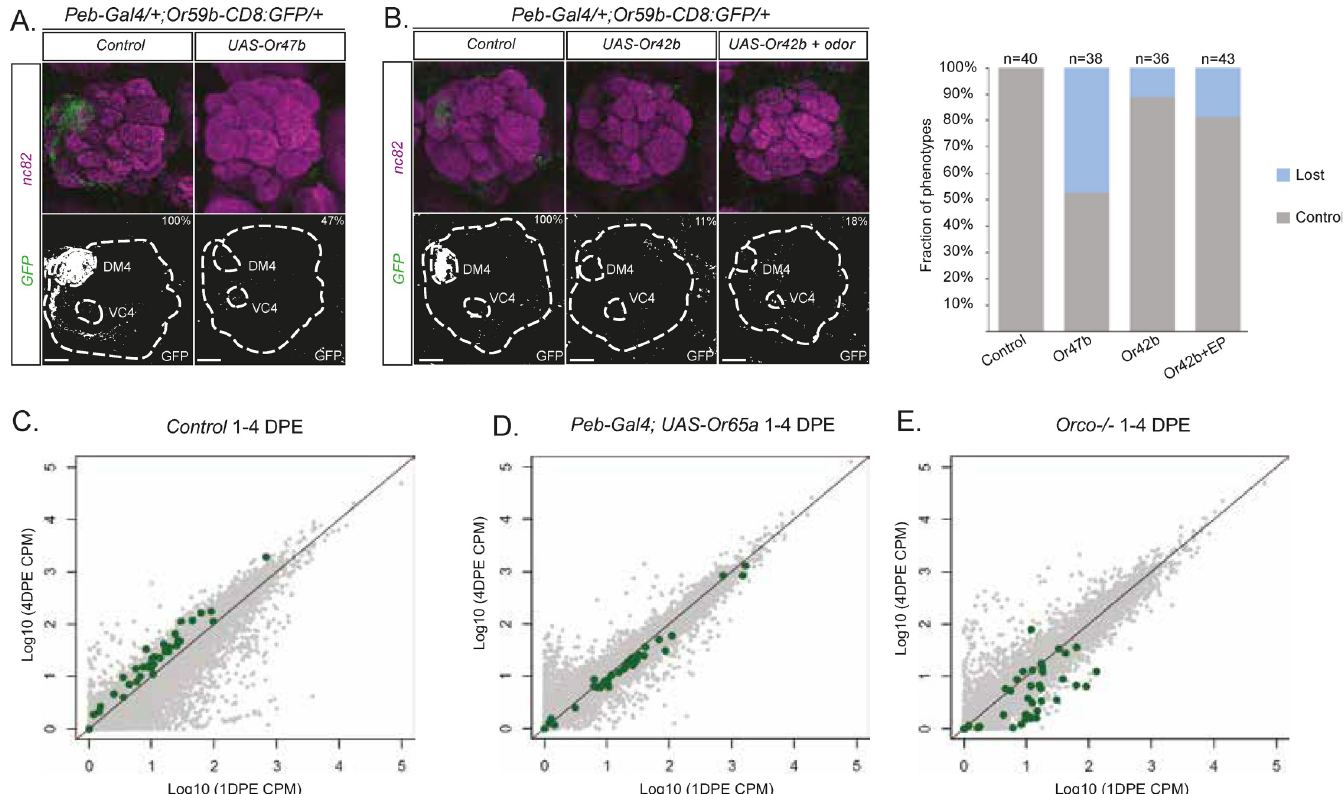
Fig 3. OR activity regulates OR expression. Or59b reporter GFP expression is shown in green, and synaptic neuropil regions are labeled with the presynaptic marker nc82 (magenta). Below each merged image, the GFP channel is shown. Antennal lobe and labeled glomeruli are marked. Control flies were crossed to w 1118 . Percentage denotes the proportion of flies with the depicted phenotype (S2 Data). Scale bar denotes 3.5 μ m. Ectopic expression of Or47b (A) or Or42b (B) inhibits Or59b reporter expression. The loss of GFP expression is greater when flies with ectopic Or42b expression are exposed to the Or42b -specific odor ligand (EP). (C–E) Degree of change in RNA sequencing read counts observed between 1 and 4 DPE. Normalized logarithmic counts (log10size-factor-normalized counts) for each gene from the respective sample were scatter-plotted. Genes shown in grey except ORs (green), for (C) control, (D) Peb-Gal4;UAS-Or65a , and (E) Orco−/− . Note that the increase in OR expression between day 1 and 4 shifts to suppression in olfactory sensory neurons with over-activity (D) and lost activity (E). The line is the reference at which gene expression is the same between conditions. Statistics for the figure are in S3 Data. The raw sequencing data are available on ArrayExpress (#E-MTAB-9805). The code is available on Github (https://github.com/henriksson-lab/mattias-or). CPM, counts per million; DPE, days post-eclosion; EP, ethyl propionate; OR, odorant receptor.